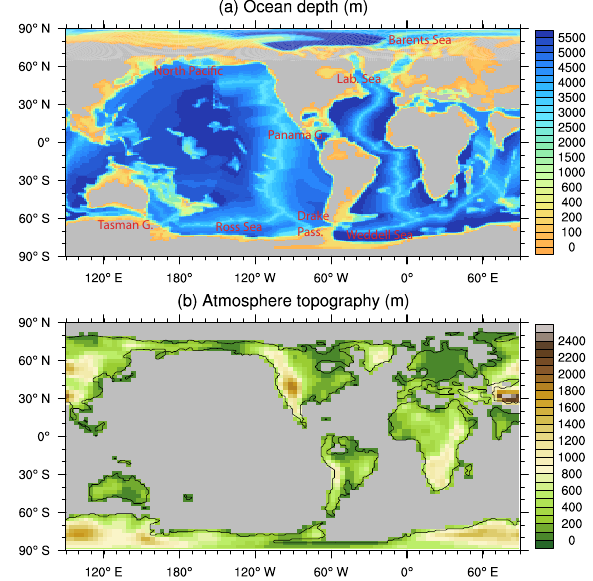
Figure 1. Bathymetry and topography of the late Eocene, adapted from Baatsen et al. (2016). Both figures are plotted using a cell fill method, illustrating the resolution of the grid cells in each case. Due to the difference in resolution between the ocean and the at- mosphere, coastal grid cells in the atmosphere typically contain a fraction of both land and